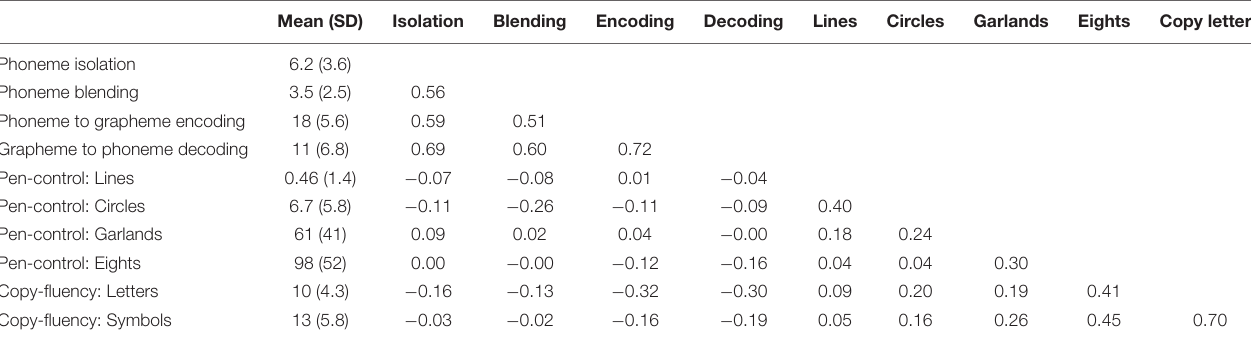
TABLE 1 | Mean scores and bivariate correlations among letter-knowledge, pen-control, and copying letters and symbols fluency measures. Mean (SD) Isolation Blending Encoding Decoding Lines Circles Garlands